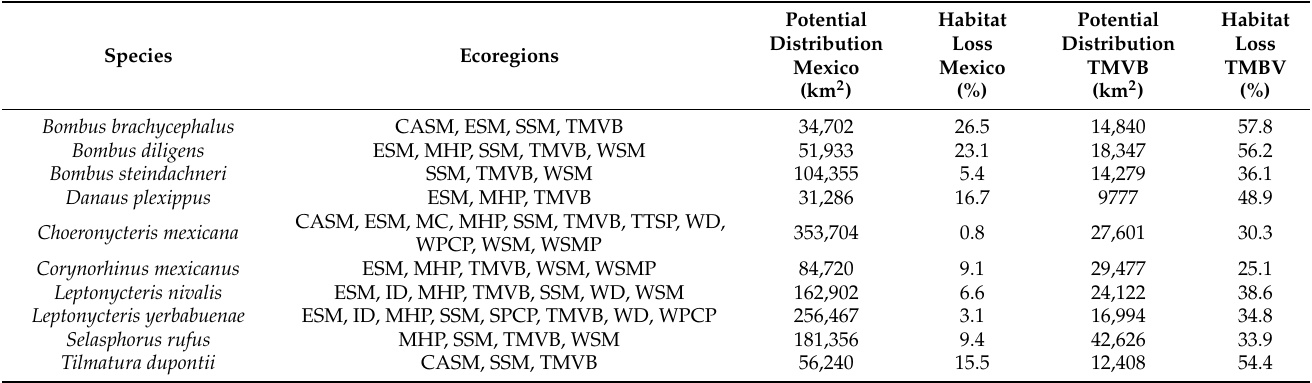
Table 4. Potential distribution and habitat loss of ten threatened pollinator species due to the expansion of Hass avocado monoculture in